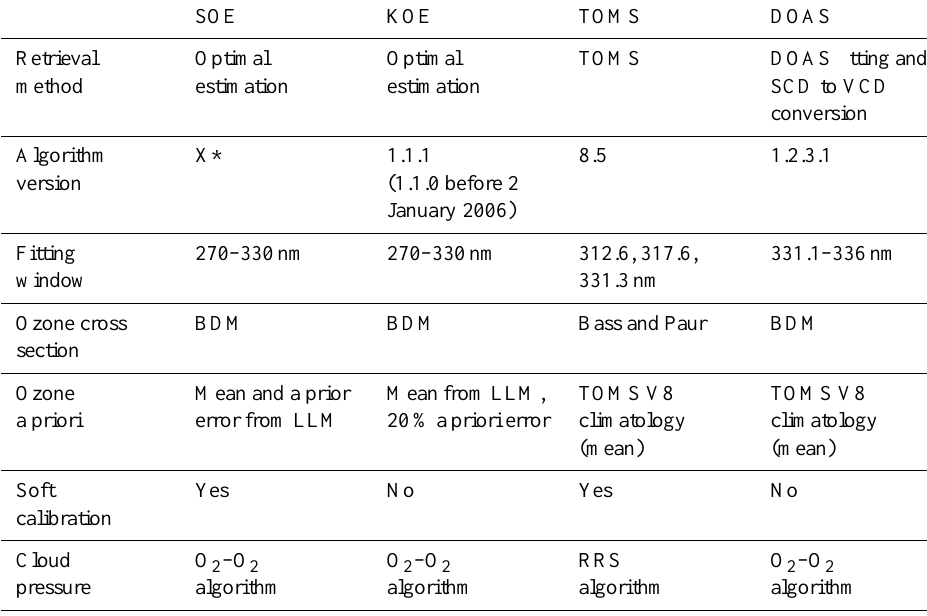
Table 1. Main Characteristics of SOE, KOE, TOMS, and DOAS ozone algorithms.